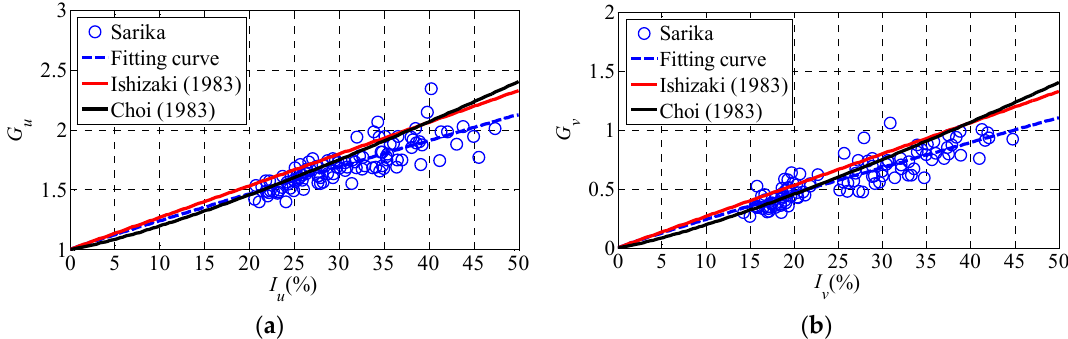
Figure 10. The relationship between gust factor and turbulence intensity. ( a ) Longitudinal gust factors; ( b ) Lateral gust factors.